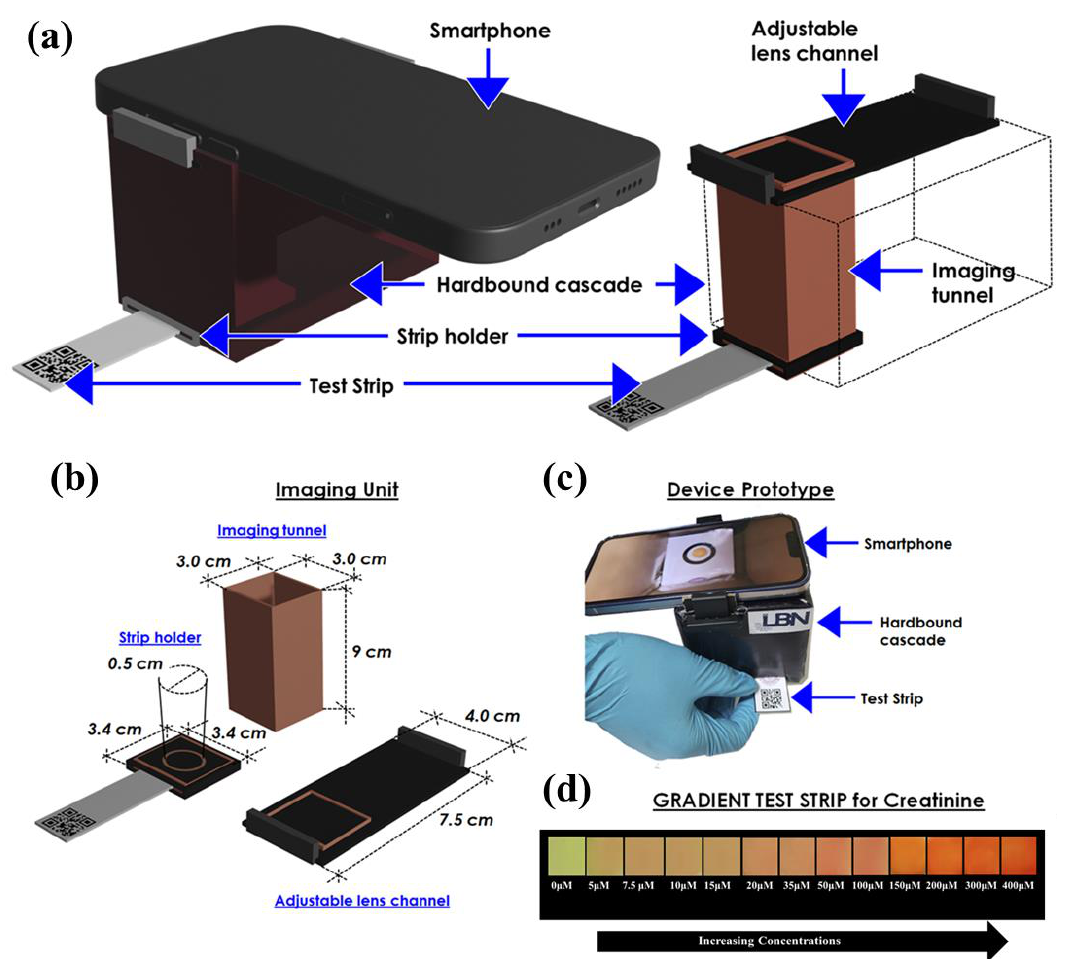
Figure 7. ( a ) Detailed design of the device setup developed for the creatinine measurement; ( b ) Detailed dimension of the designed tunnel and the strip for image capturing and processing; ( c ) Real image of the developed system taking reading for creatinine detection; and ( d ) gradient strip for qualitative detection of